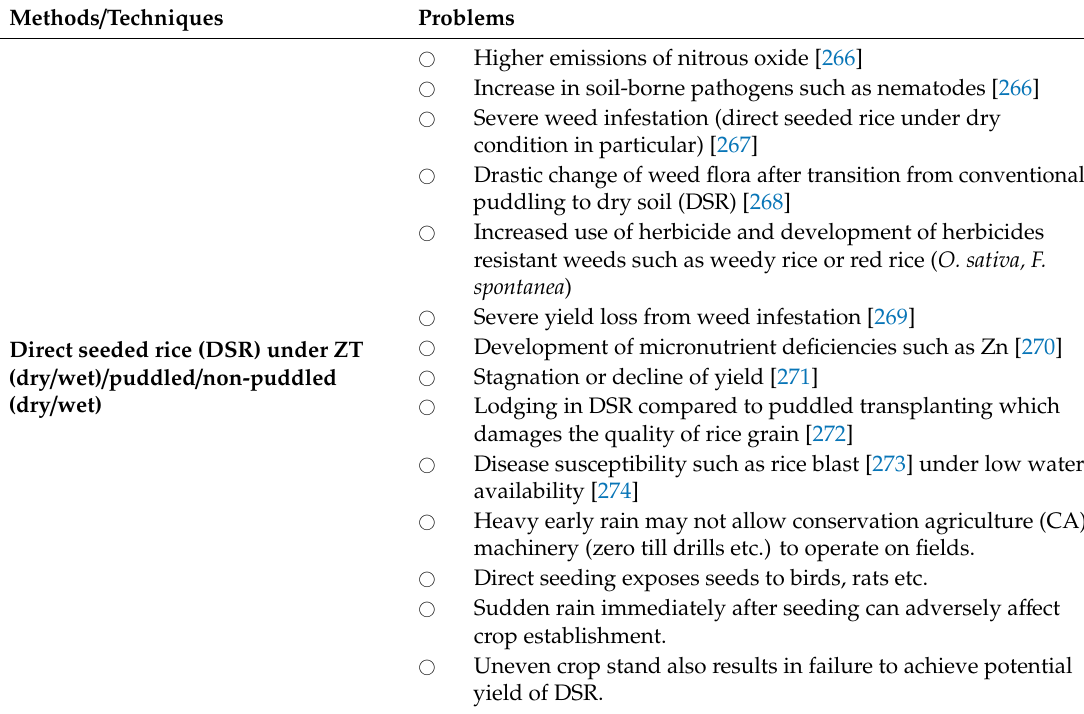
Table 3. Problems Reported for Rice Crop Establishment